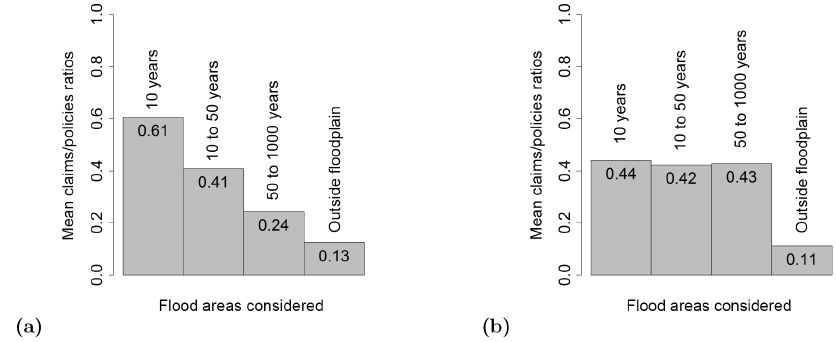
Figure 4. Spatial distribution of mean claims / policies ratios, inside and outside the floodplains: (a) Alès 2002 event, (b) Draguignan 2010 event. Table 2. Mean claims / policies and policies / buildings ratios computed inside the 1000-year floodplains for the September 2002 and June 2010 events. The claims and policies are those selected in the CCR database according to the rules described in Sect. 3.6. The buildings considered are those of less than 7m height according to the IGN BD Topo